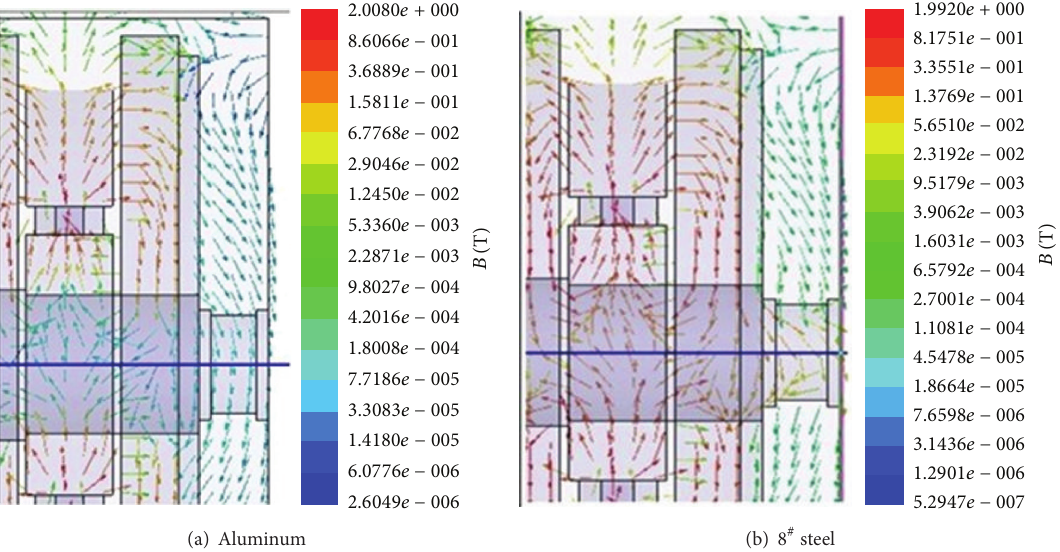
Figure 4: Cloud charts of magnetic lines of force for arbor shaft in aluminum and 8 # steel.